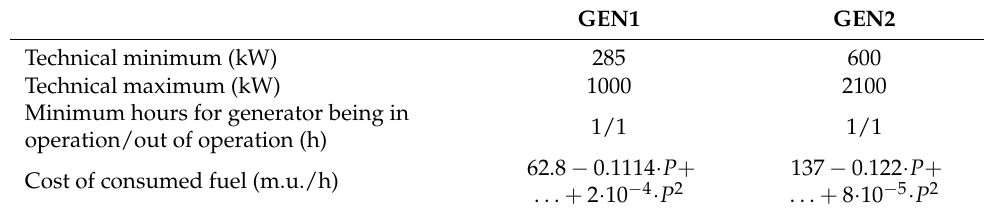
Table 6. Diesel generators’ model data.